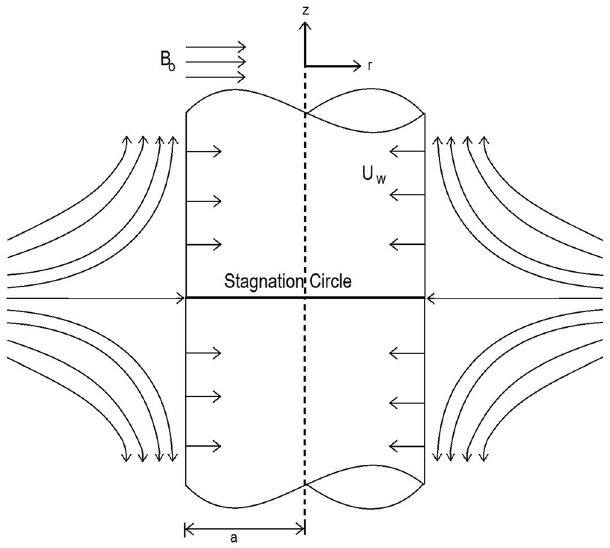
Figure 1. Physical configuration and coordinate